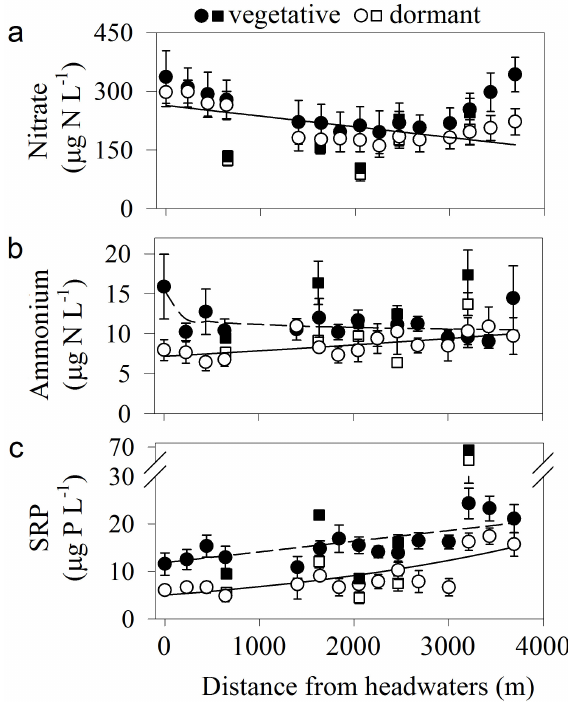
Figure 5. Longitudinal pattern of stream nutrient concentrations for (a) nitrate, (b) ammonium, and (c) solute reactive phosphorus at Font del Regàs. Symbols are average and standard error (whiskers) for the main stream (circles) and tributaries (squares). Lines indicate significant longitudinal trends for the dormant (solid) and vegetative (dashed) period (tributaries not included in the